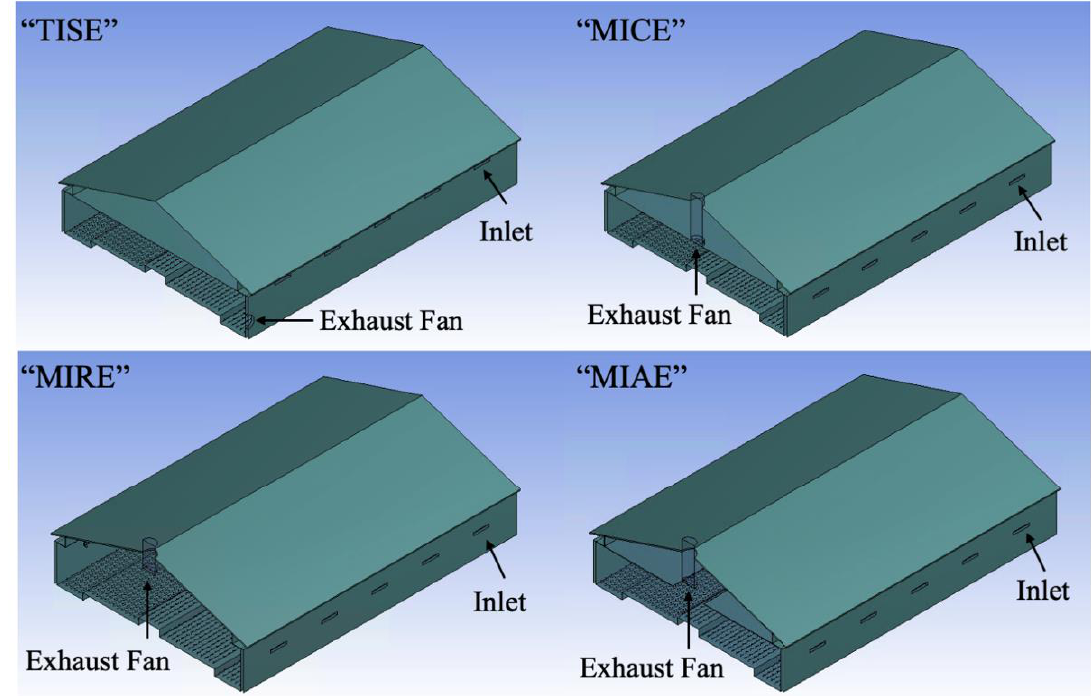
Figure 2. Geometry of the study layer house with the standard ventilation scheme (TISE) and three alternative ventilation designs (MICE, MIRE, and MIAE). Arrows indicate locations of inlets and the exhaust fan.